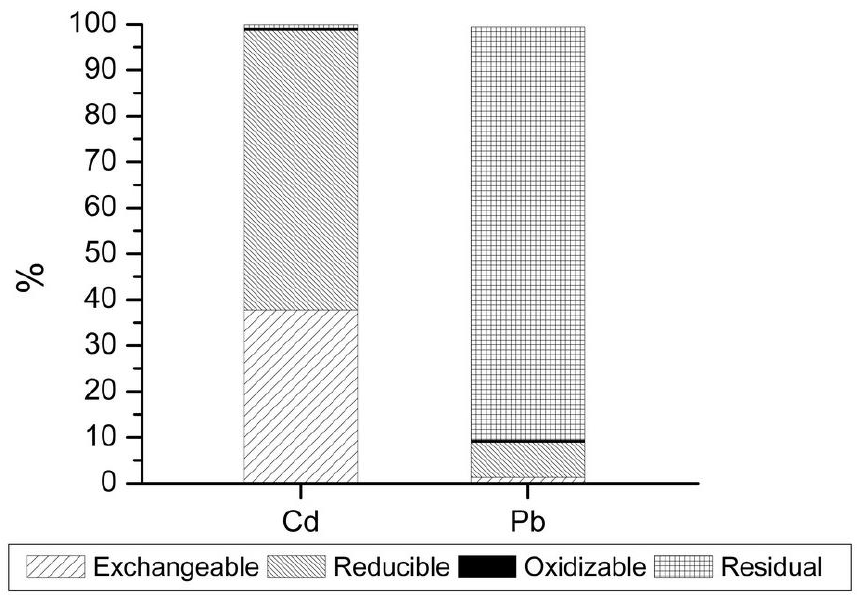
FIGURE 1 . Distribution of Cd and Pb in sequentially extracted fractions of untreated sediment